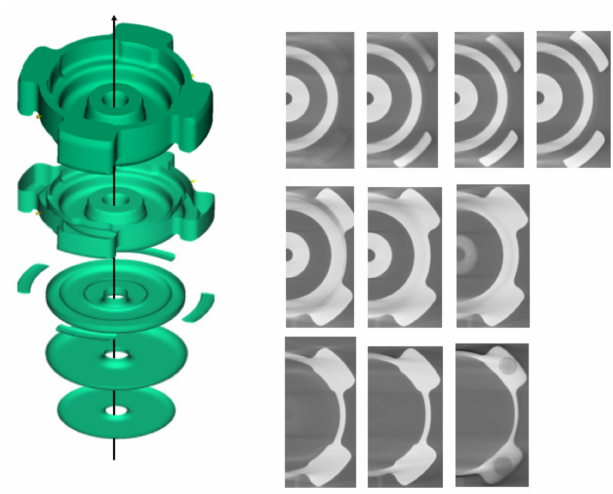
Figure 6. XCT images along the axis (black